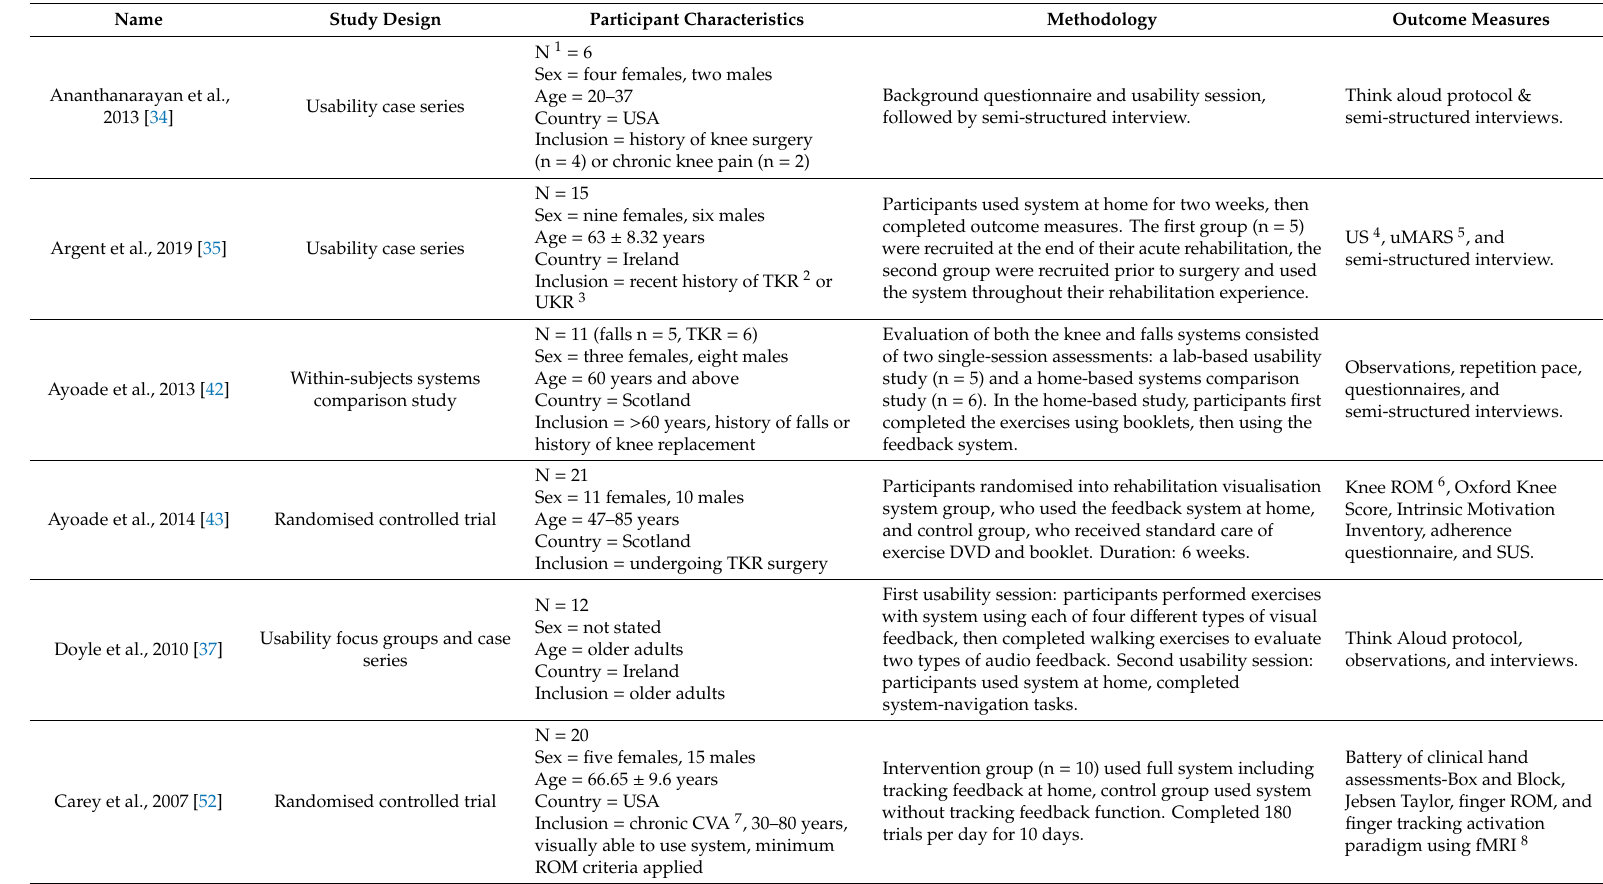
Table 4. Evaluation of